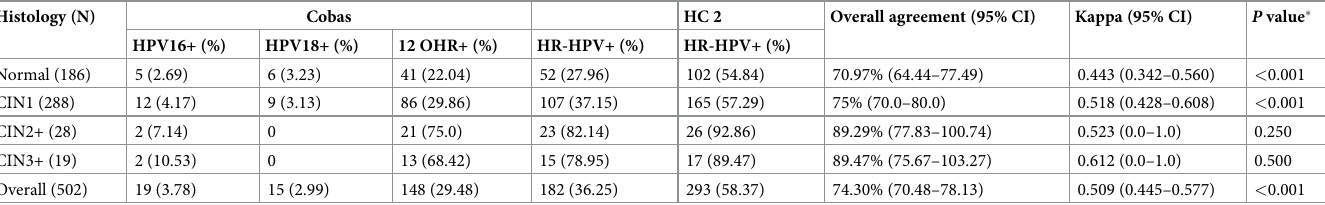
Table 4. HPV prevalence and concordance analysis of Cobas and HC2 tests stratified by histology. Histology (N)